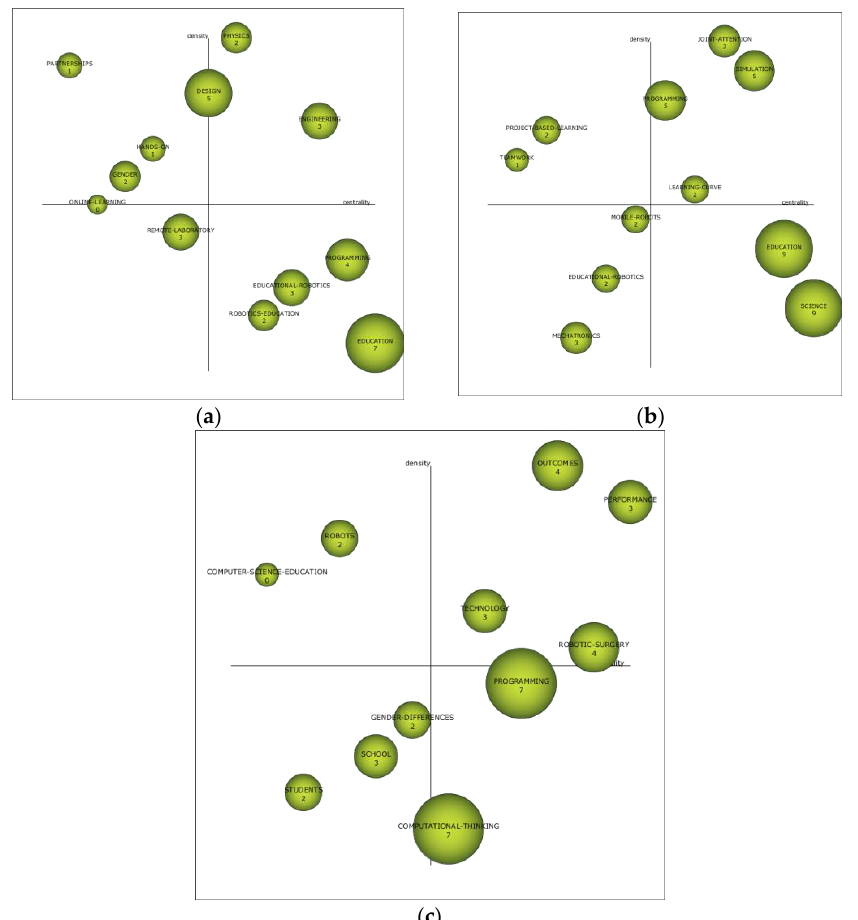
Figure 5. Strategic diagrams by ROBEDU h-index: ( a ) interval 1975–2012; ( b ) interval 2013–2016; and ( c ) interval 2017–2019.